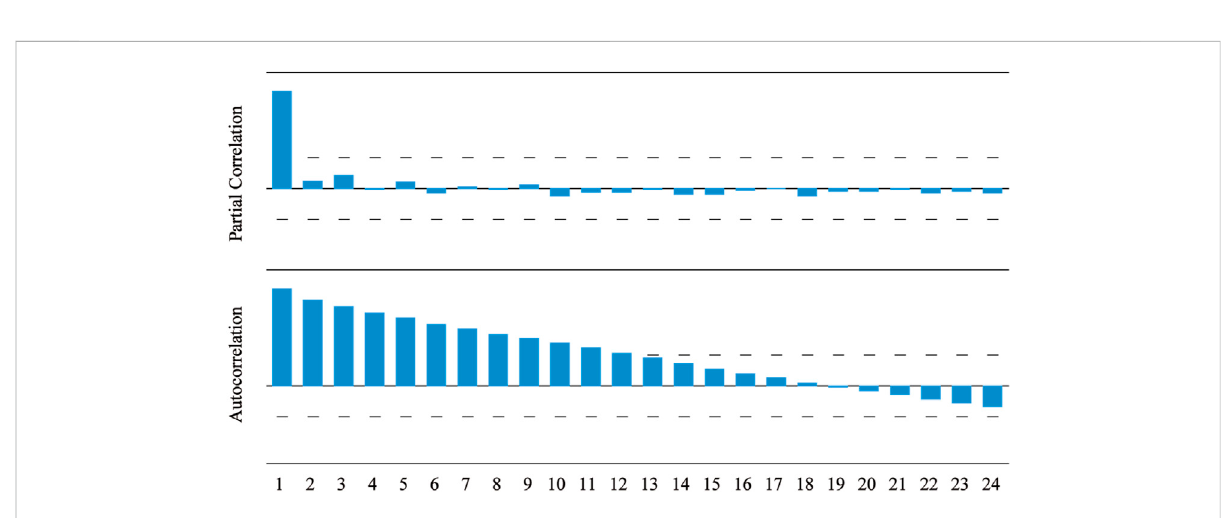
FIGURE 8 Stationarity test of the coal price time series.